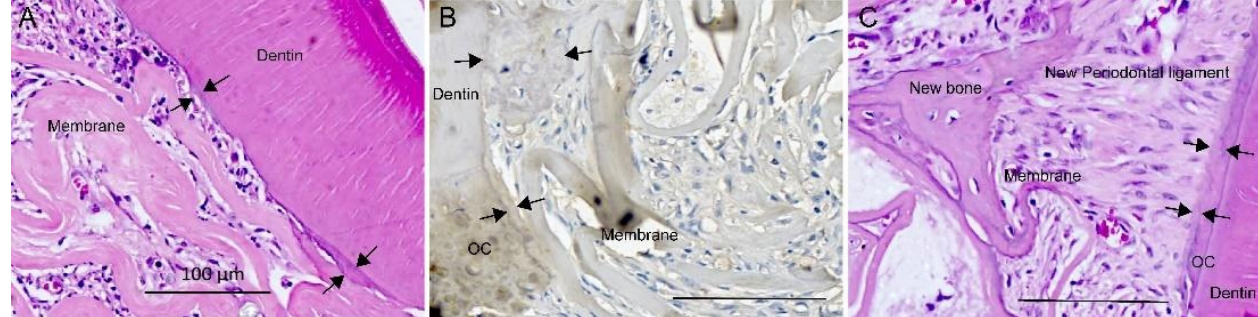
Figure 4. Newly deposited cementum-like matrix (between arrows) observed as a thin metachromatic adherent layer on exposed dentin ( A , B ) and exposed old cementum (OC) ( B , C ), as thin acellular cementum layer and thick cellular cementum ( B ). Organization of new periodontal ligament ( C ) with periodontal ligament tissue fibers oriented perpendicular to cementum between cementum-like matrix and the newly deposited bone matrix in the niche created by collagenous fibers of the amniotic membrane ( C ). Transplantation of decellularized amniotic membrane (DAM) (T1) ( A ), DAM associated with extracellular matrix and undifferentiated adipose-derived stromal cells (T4) ( B ), DAM associated with extracellular matrix (T3) ( C ). H&E stain ( A , C ); immunohistochemistry anti-osteocalcin ( B ); scale bars 100 µ m ( A – C ).